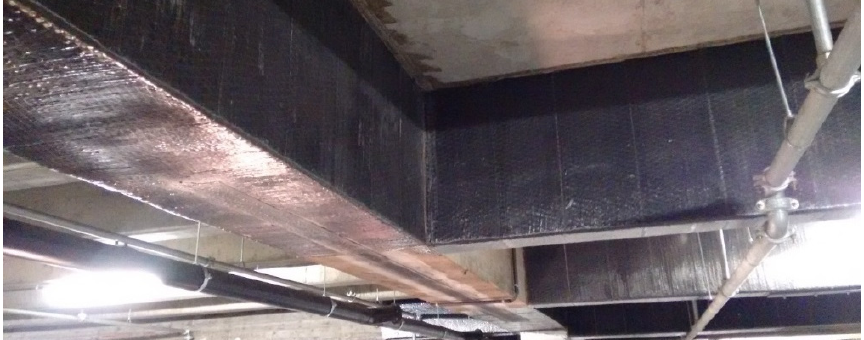
Figure 3. Example of FRP strengthening of beams in Ghent,